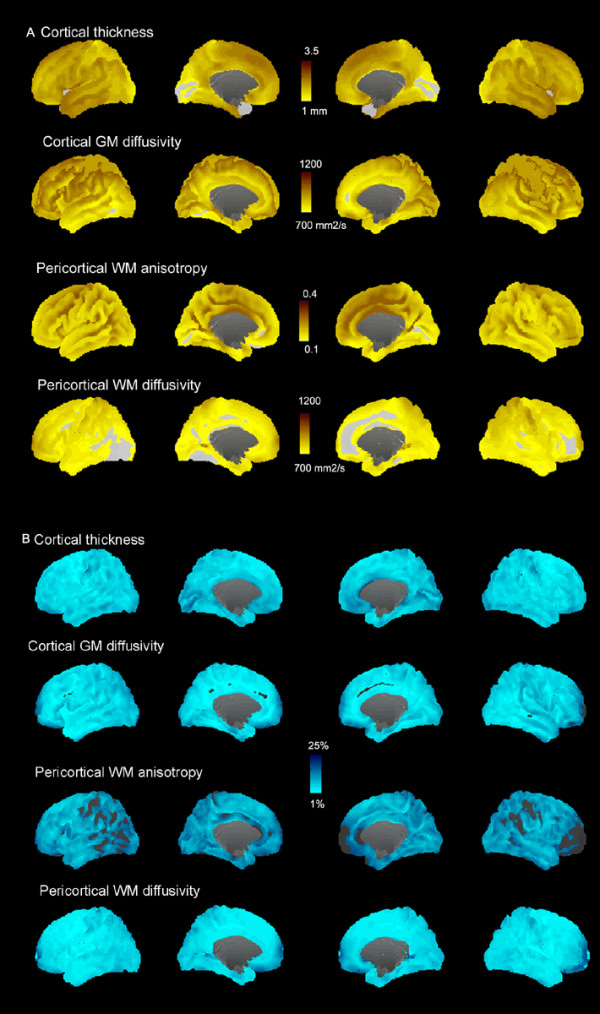
A, B. Cortical gray matter and pericortical tissue properties quantified along the cortical mantle in control subjects. Mean values (A) and variability (B, coefficient of variation) for cortical thickness, cortical mean diffusivity, and fractional anisotropy and mean diffusivity of pericortical white matter (2 mm below the gray-white boundary) for control subjects are shown for each point on the surfaces of the two hemispheres. The corpus callosum is cut out, and the regions with very low values (e.g., thickness < 1 mm, coefficient of variation < 1%) appear in gray.